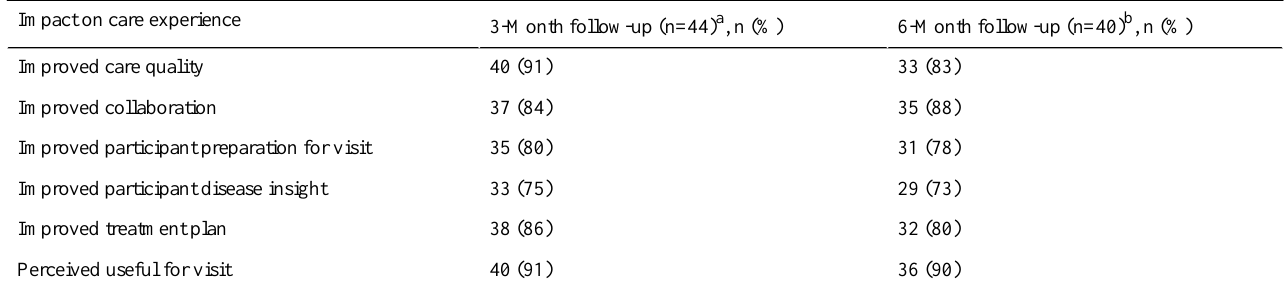
Table 2. Percentage of Orchestra users reporting that the tool improved their care experience.